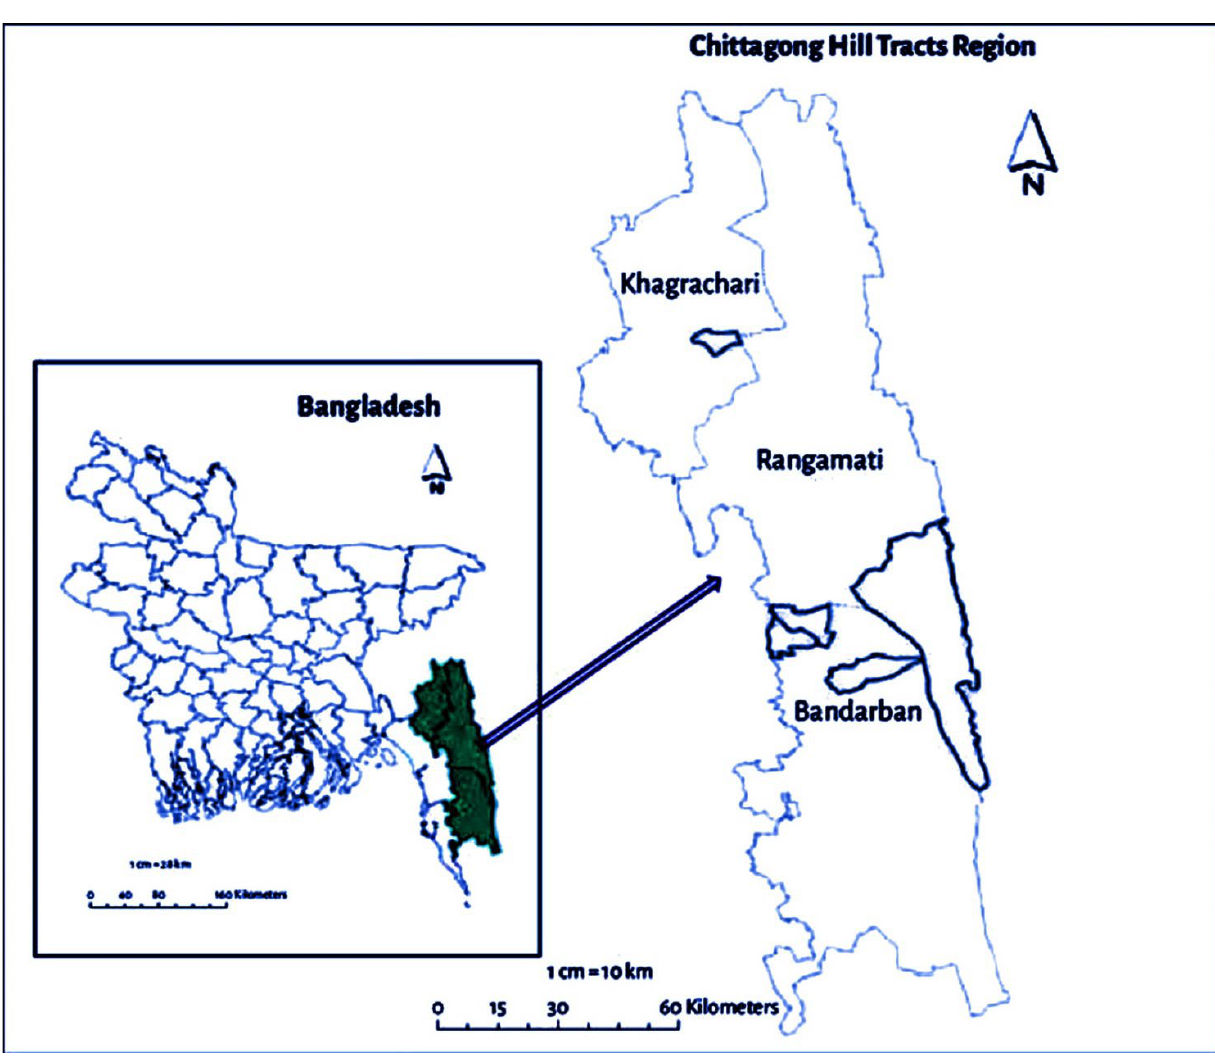
Figure 2. Location of the study area.